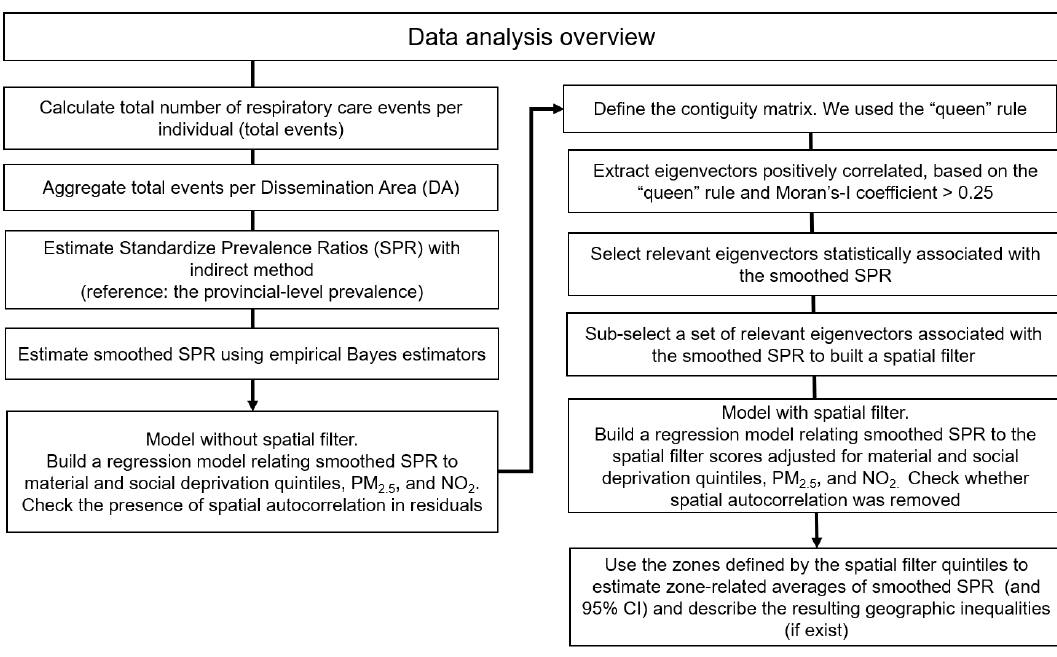
Figure 1. Data analysis overview.